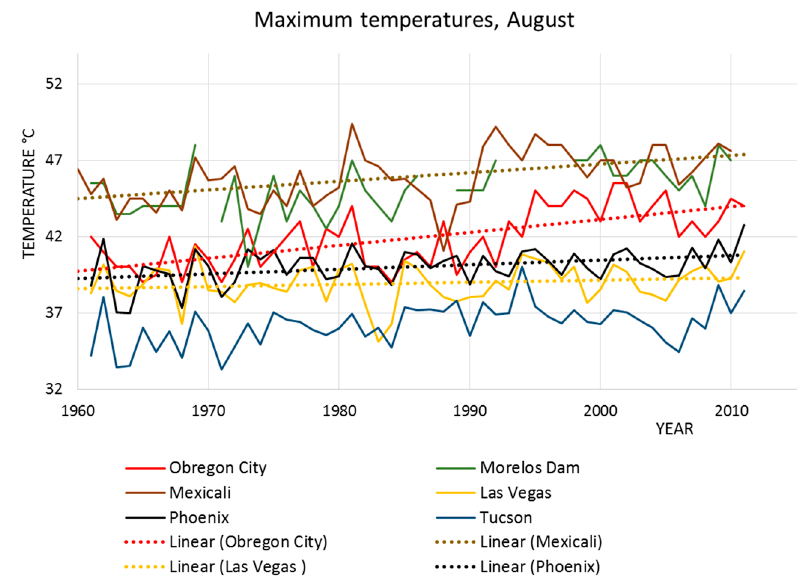
Figure 2. Maximum monthly temperature variations and linear trend lines for August.